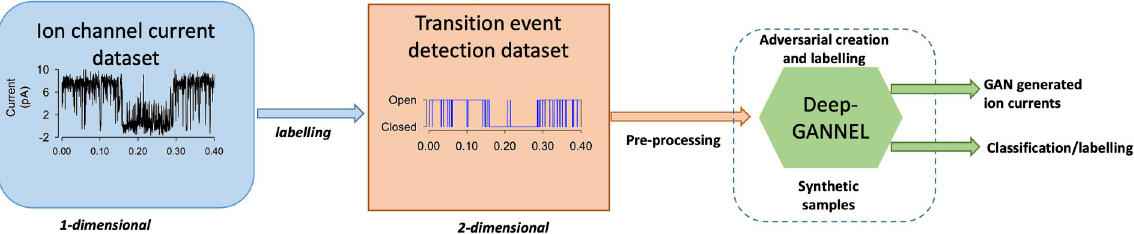
Fig 1. Pipelines for DeepGANnel development. Data are recorded using standard electrophysiological techniques. These raw data are then labelled using existing software and expert supervision. Pre-processing makes copies of these data adding a small amount of gaussian noise to the raw data and reshapes the two signals into 2D “images”